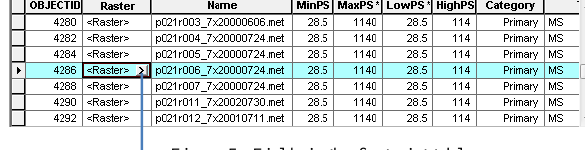
Figure 5. Fields in the footprint table